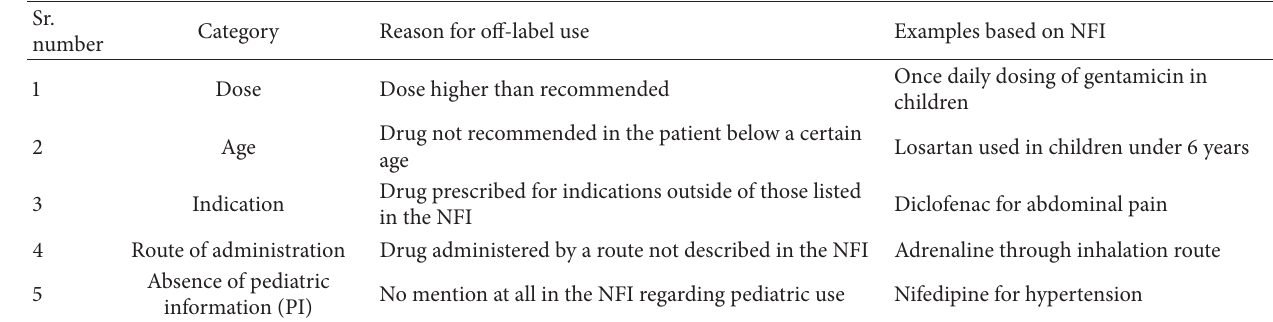
Table 1: Off-label medicine use